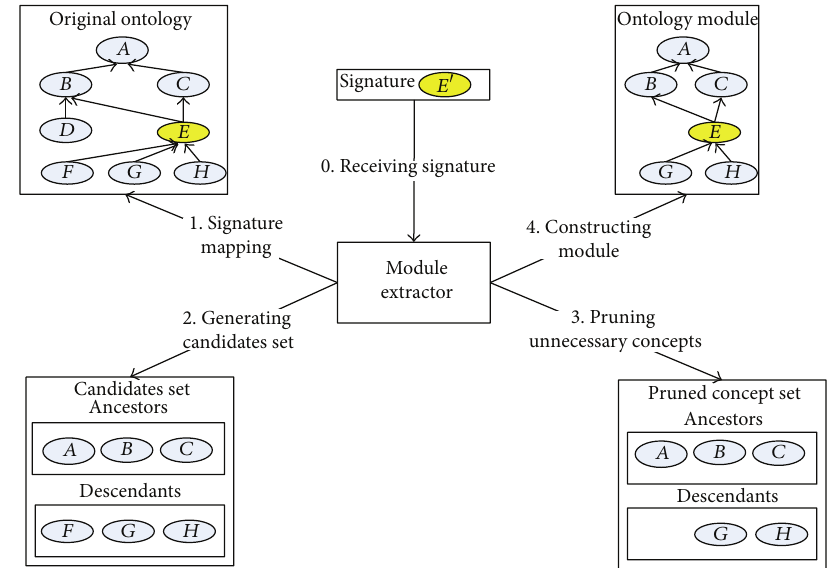
Figure 2: Process of module